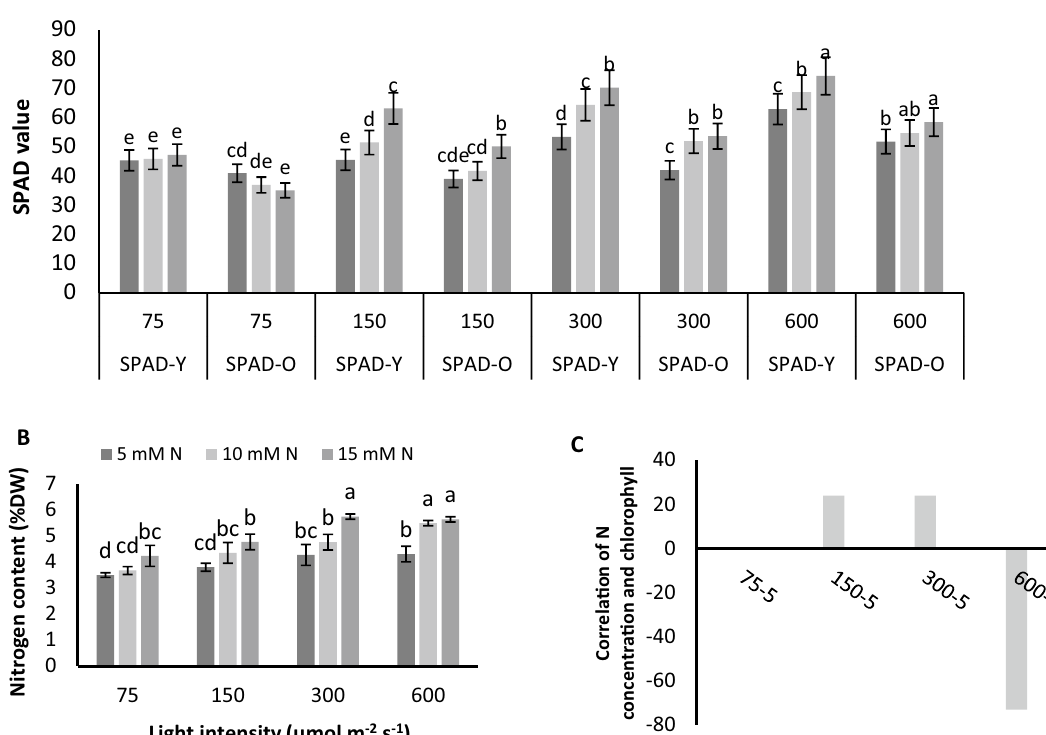
Figure 2. Chlorophyll content of the leaves ( A ), Nitrogen content of leaves ( B ), and the correlation between N and chlorophyll cntent ( C ) of the leaves of chrysanthemum plants grown under different light intensits (75, 150, 300, and 600 µmol m −2 s −1 ) and nitrogen (N) concentrations (5, 10, and 15 mM N) at 70 days of cultivation. Vertical bars are means ± SD. Within each graph, interactive effects of light intensity and nitrogen concentration are shown. Different letters (a–d) denote a significant difference between treaments (P <